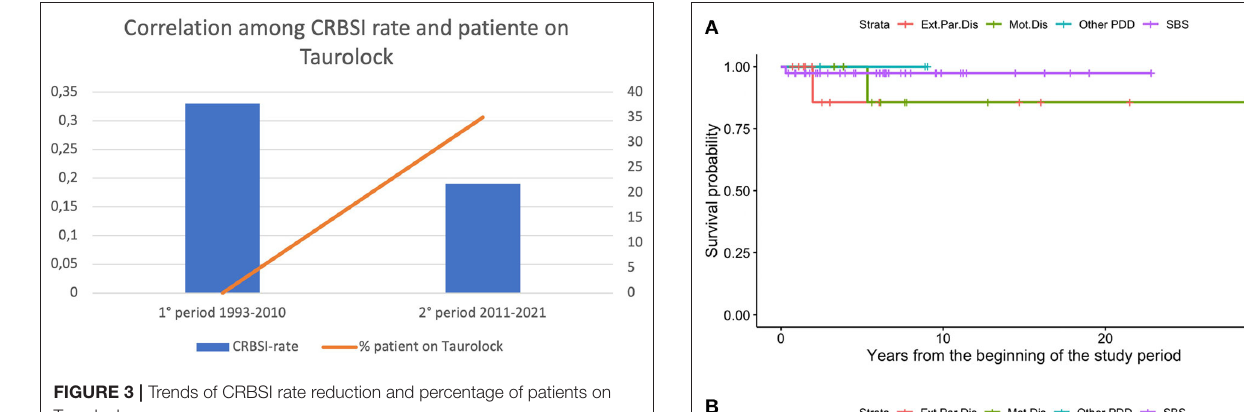
outside their region. Sixty-seven percent of the caregivers (of whom 99% were mothers) were